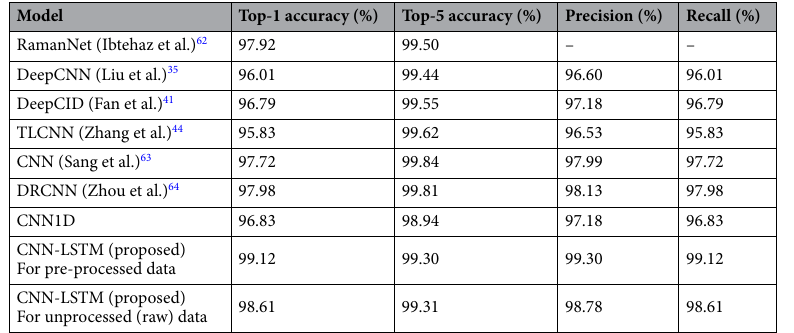
Table 1. The table benchmarks our model against the state-of-the-art models from the literature. The bold values indicate the results from our proposed model for the processed and raw